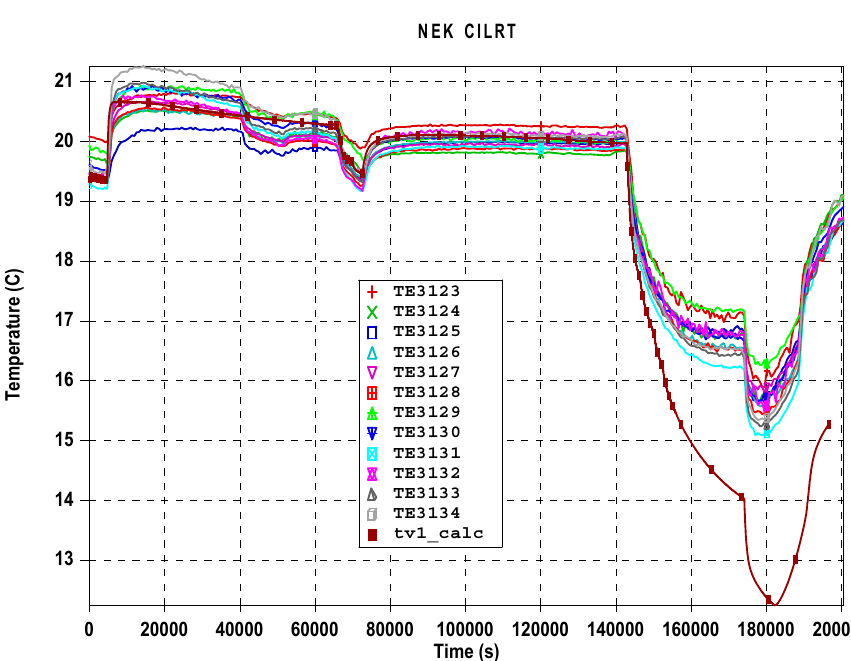
Figure 5. Measured and calculated containment temperatures during the test.